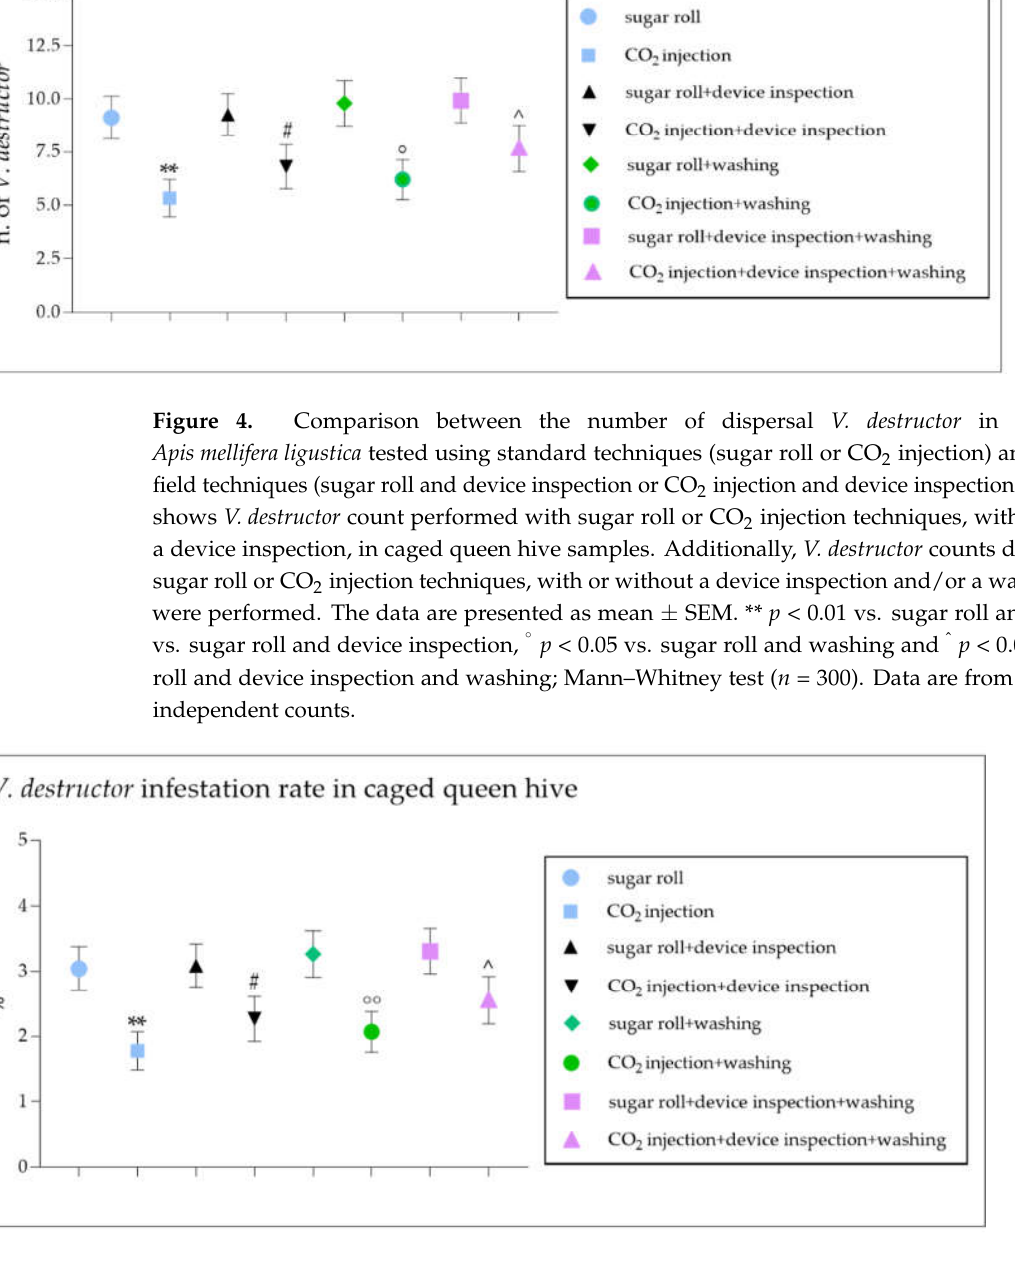
Figure 5. Comparison between V. destructor infestation rate in colonies of Apis mellifera ligustica tested using standard techniques (sugar roll or CO 2 injection) and modified field techniques (sugar roll and device inspection or CO 2 injection and device inspection). The graph shows the percentage of V. destructor infestation performed with sugar roll or CO 2 injection techniques, with or without a device inspection and/or a water washing, in caged queen hive samples. The data are presented as mean ± SEM. ** p < 0.01 vs. sugar roll, # p < 0.05 vs. CO 2 injection, °° p < 0.01 vs. sugar roll and washing and ^ p < 0.05 vs. sugar roll and device inspection and washing; Mann–Whitney test ( n = 300). Data are from 15 different independent counts.